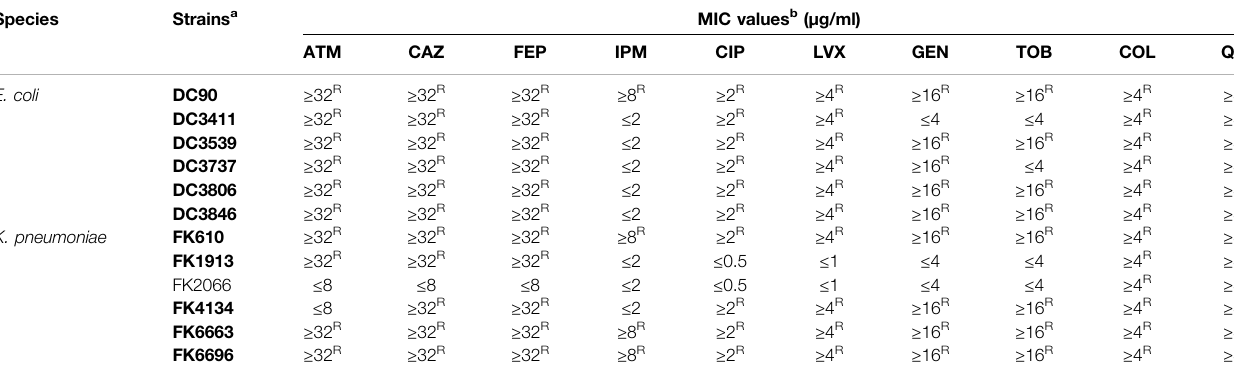
a Strain numbers in bold indicate they are multi-drug resistant. b Values in bold indicate bacterial